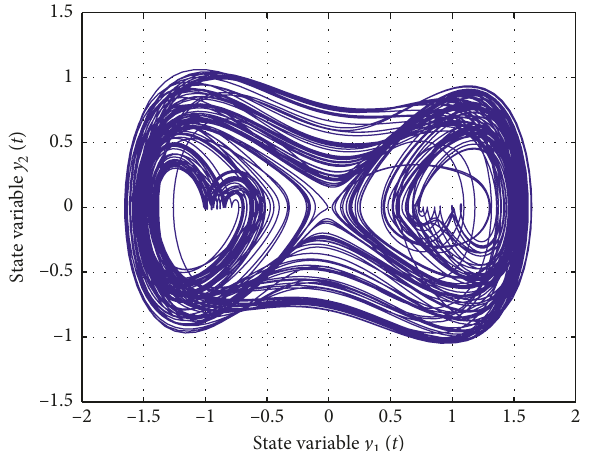
Figure 9: The simulation result for the master